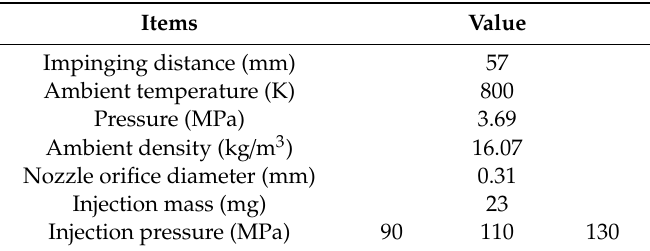
Table 2. Specific experimental